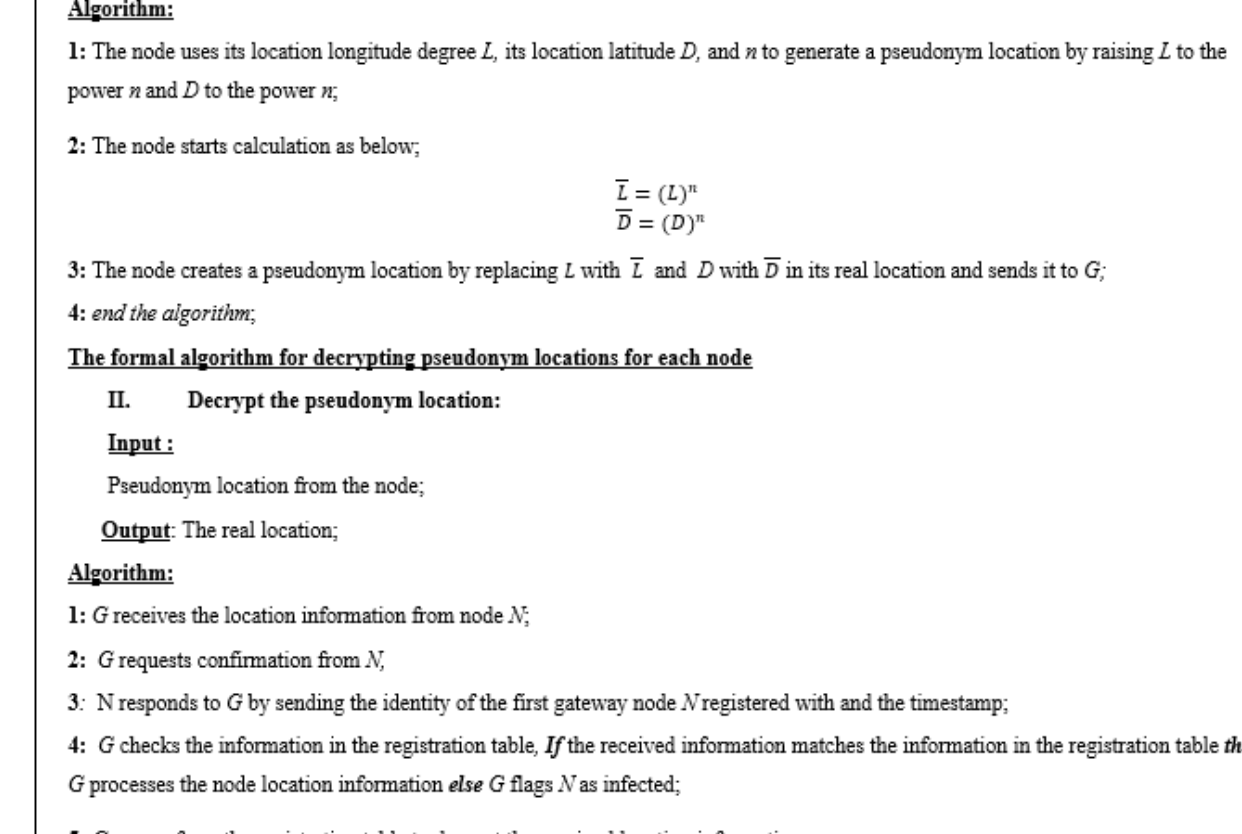
Figure 7. The formal algorithm to generate pseudonym